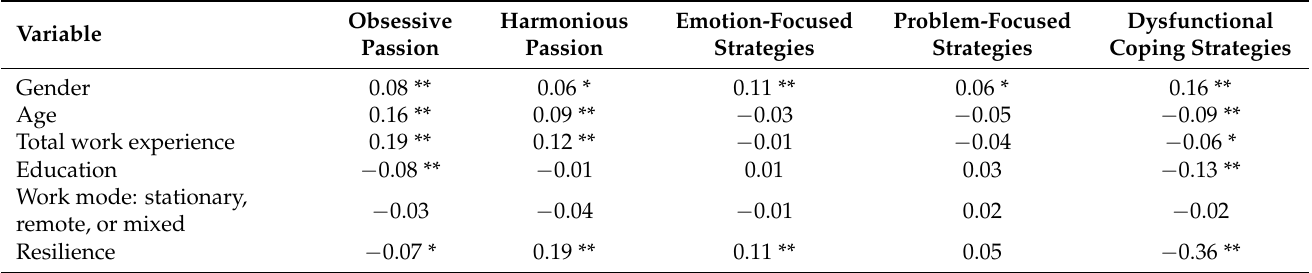
Table 3. Correlations between the sociodemographic variables, work mode, and resilience and passion for work and strategies of coping with